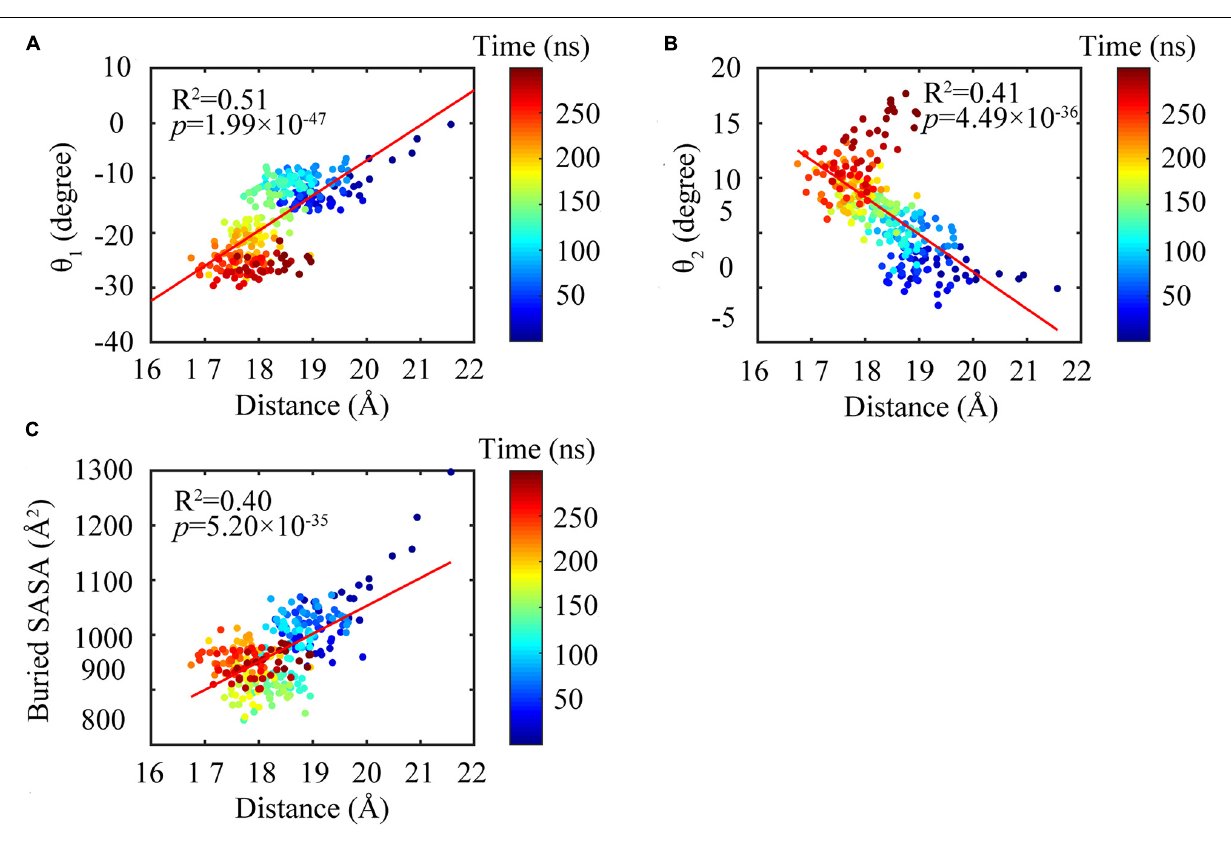
speed of the T-to-R transition for GDP-bound middle subunit ( Supplementary Figure 4 , green line) is slower than that of the bottom end subunit ( Supplementary Figure 4 , red line). Dajkovic et al. proposed a related model in which two R subunits switch to T and then associate to make a T-T dimer (Dajkovic et al., 2008). This will lead to a subcategory dimer T-T (top- middle) in one GTP-bound simulation while in the